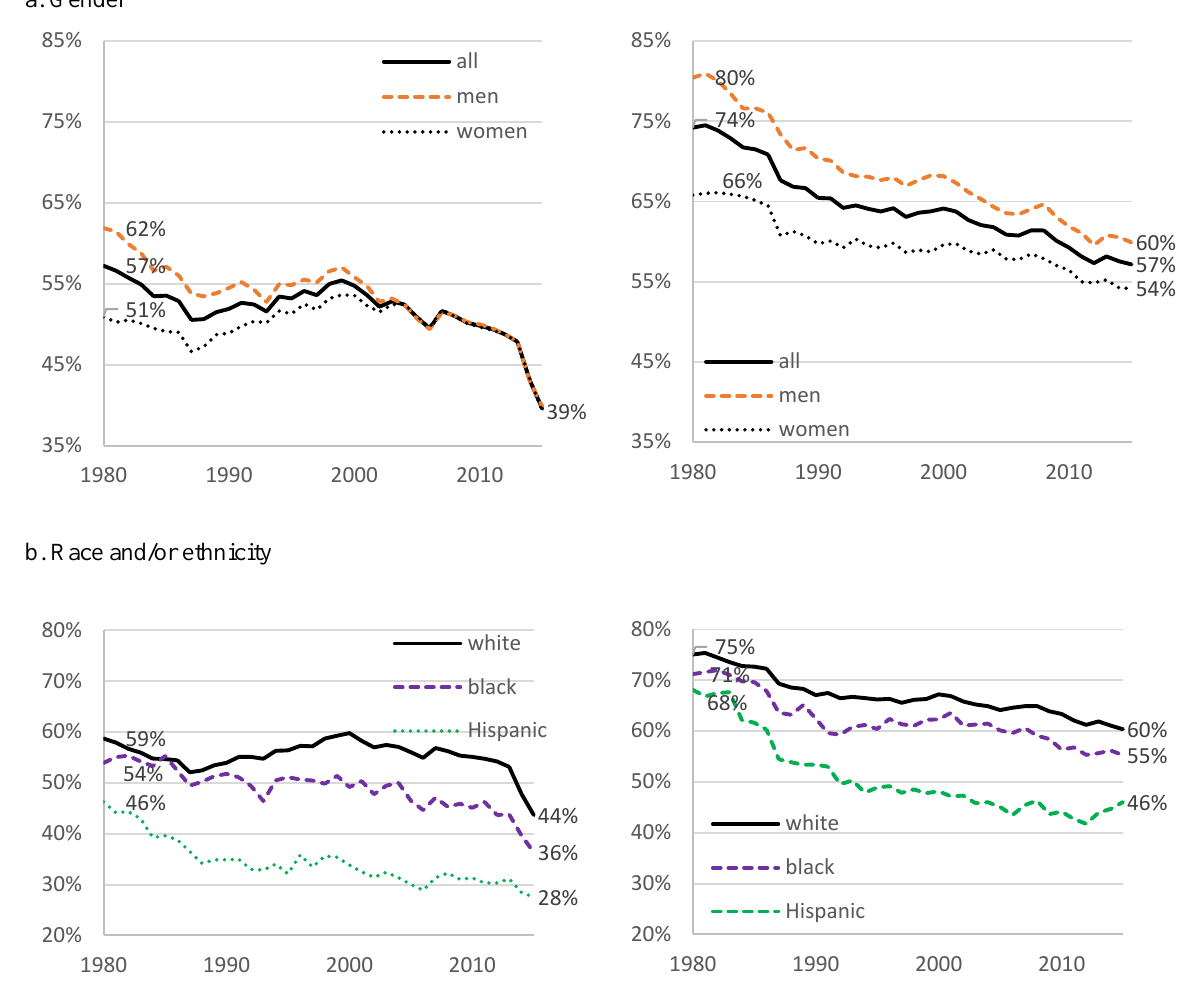
Figure 2: Employer-provided pension coverage (left) and employer-provided health insurance coverage (right) by gender and race and/or ethnicity, 1980–2015. Notes: Private industry (and state and local government sector) wage and salary workers aged 18 to 65 who worked at least 20 hours per week and 26 weeks per year. Coverage is defined as being included in an employer-provided plan for which the employer is paid at least some of the coverage. Race and/or ethnicity categories are mutually exclusive (i.e., white non-Hispanic, black non-Hispanic, and Hispanic any